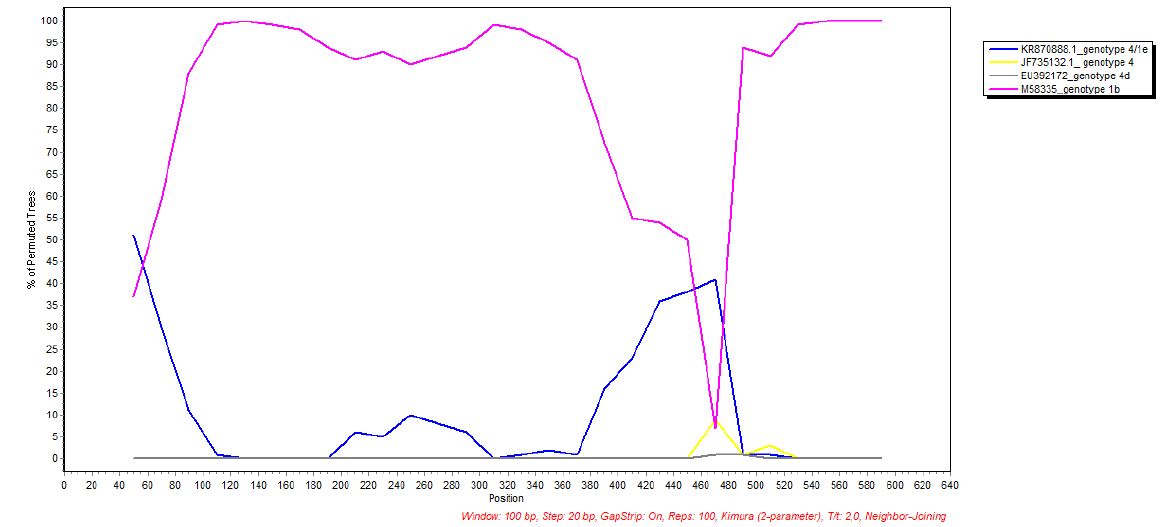
Figure 2. Bootscan plot of the NS3 region of our strain (BS172021) generated using the SimPlot software. It displays the bootstrap support for the clustering of the BS172021 NS3 region with 3 genotype reference genomes in 100-nt-sliding windows, 10 nt increments, and the Kimura 2-parameter model method with a transition-transversion (Ts/Tv) ratio of 2.0 across the viral genome. The curves are colored in yellow, blue, pink, and grey according to the genotype key on the right.